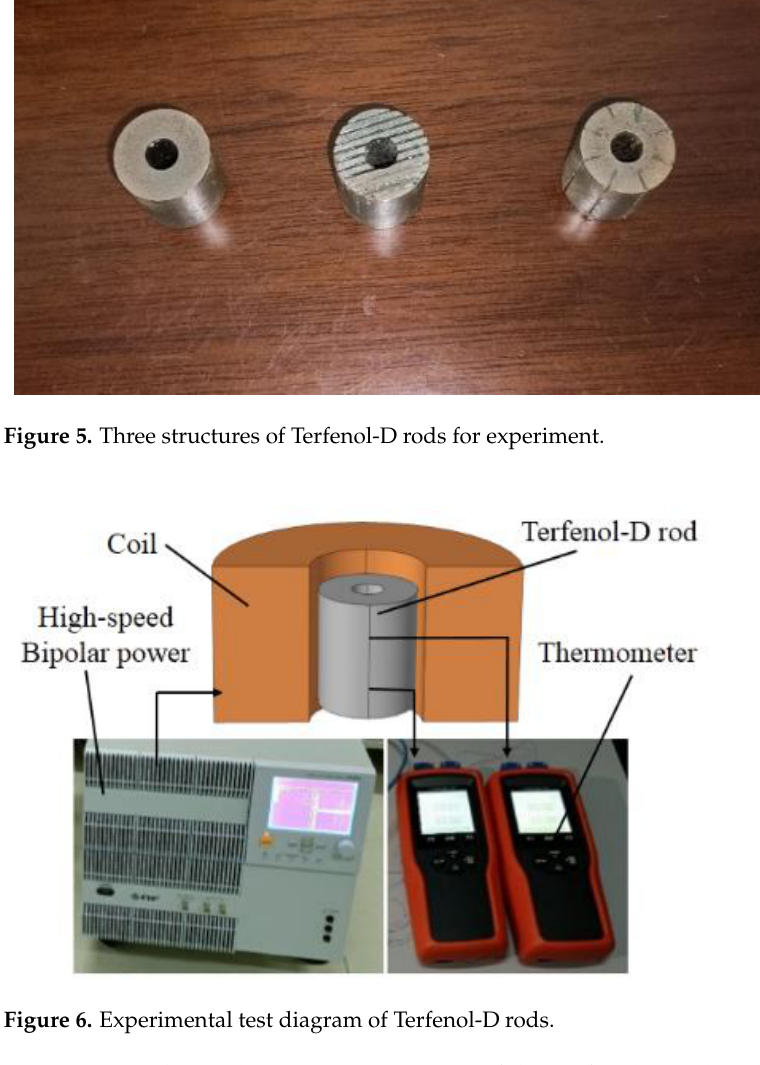
Figure 6. Experimental test diagram of Terfenol-D rods.